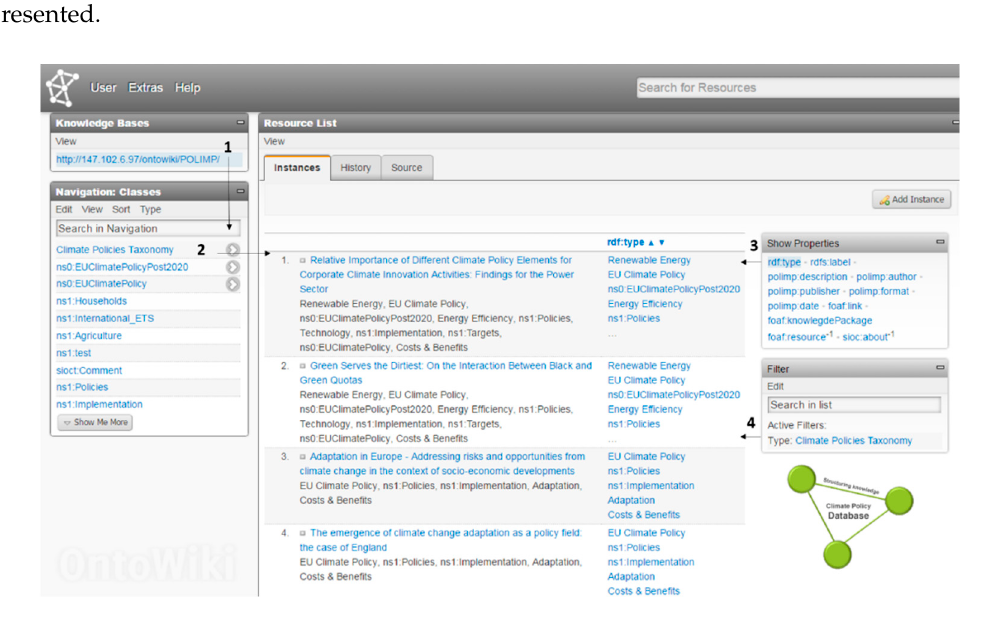
Figure 4. The Climate Policy Database: (1) Selection of a knowledge base; (2) Selection of a class; (3) Selection of additional properties to be shown as columns in the list; (4) Further restriction of the resources in the list.